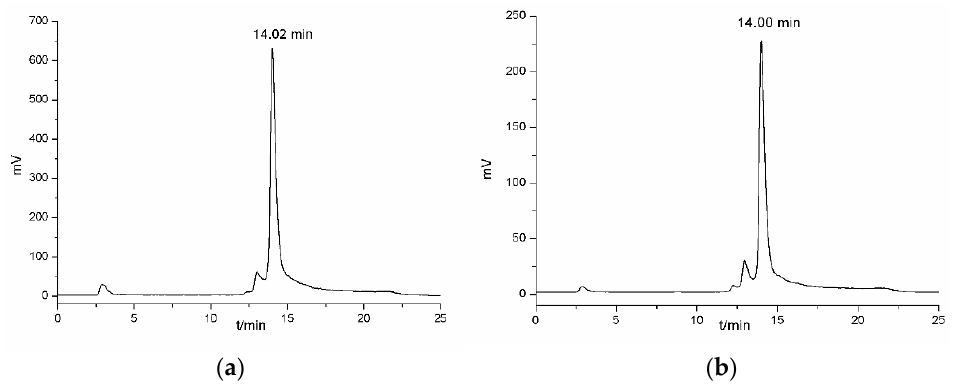
Figure 2. ( a ) HPLC profiles of [ 99m Tc]Tc-CN4NF and ( b ) [ 99m Tc]Tc-CN5NF.